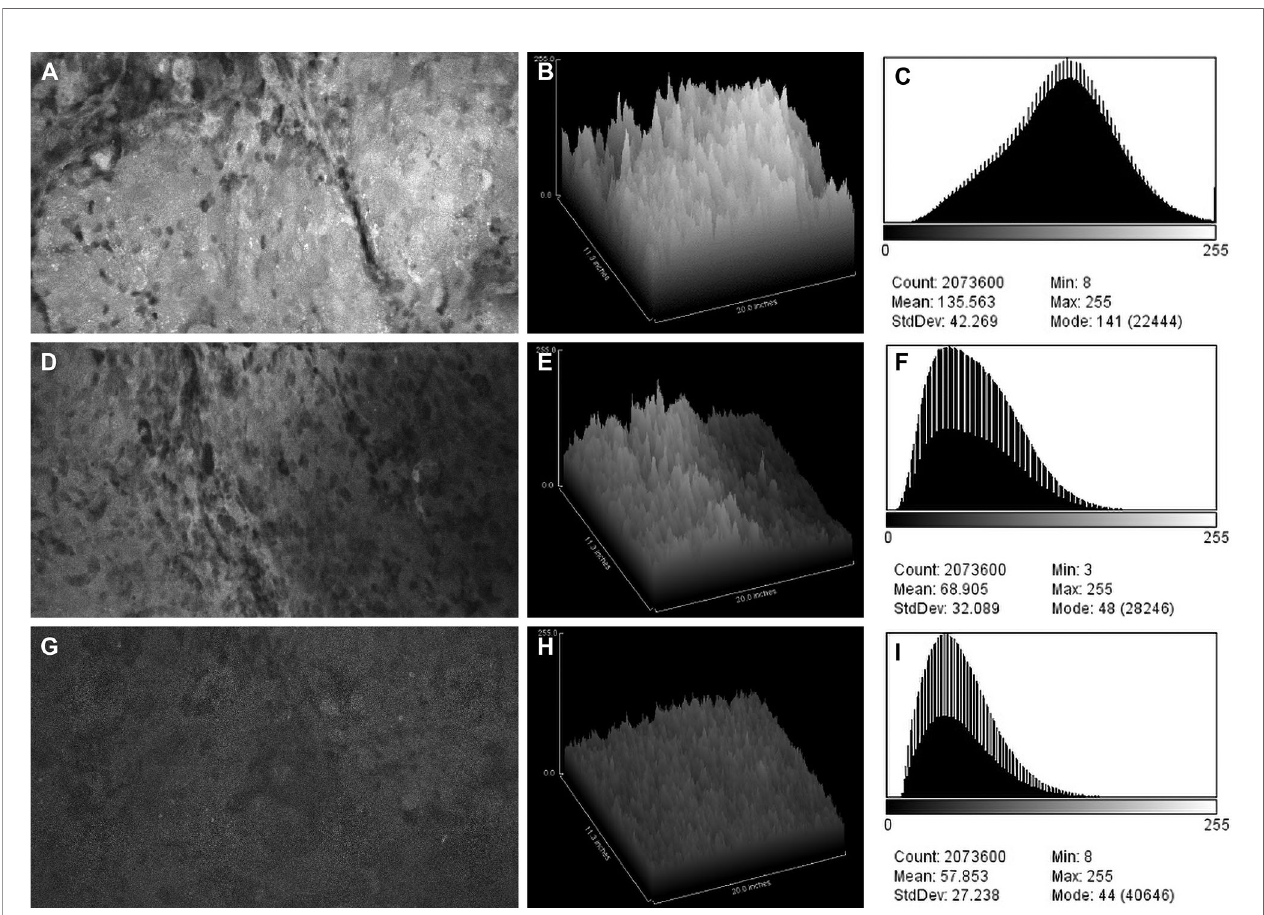
FIGURE 2 | Confocal laser endomicroscopy (CLE) images and data from (A – C) the fl uorescein sodium redose, (D – F) initial-dose, and (G – I) single-dose groups. A CLE image (A, D, G) from each group is shown with a corresponding three-dimensional surface plot of pixel intensities (B, E, H) and a histogram of intensity values (C, F, I) . Count, number of pixels; Mean, brightness; StdDev, contrast; Min and Max, minimum and maximum gray values within the image; Mode, most frequently occurring gray value within the selection corresponds to the highest peak in the histogram. Used with permission from Barrow Neurological Institute, Phoenix,